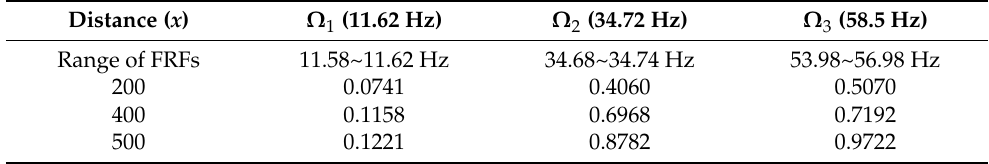
Table 1. Summary of the impact hammer test on a both-end-fixed beam.